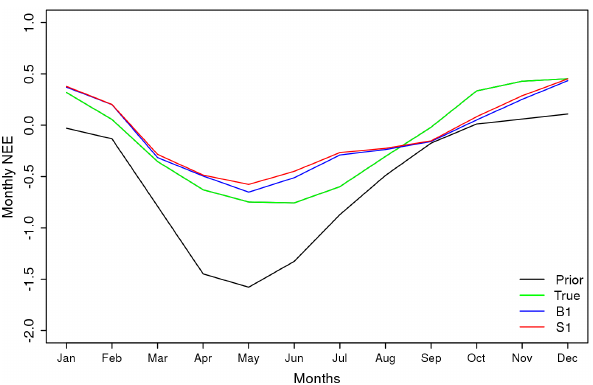
Figure 10. Mean monthly NEE averaged over the 53 different eddy covariance site locations as reported in Kountouris et al. (2015). A priori (black), true (green) and posterior fluxes for scenarios B1 (blue) and S1 (red) are shown. Units are in gCm − 2 day − 1